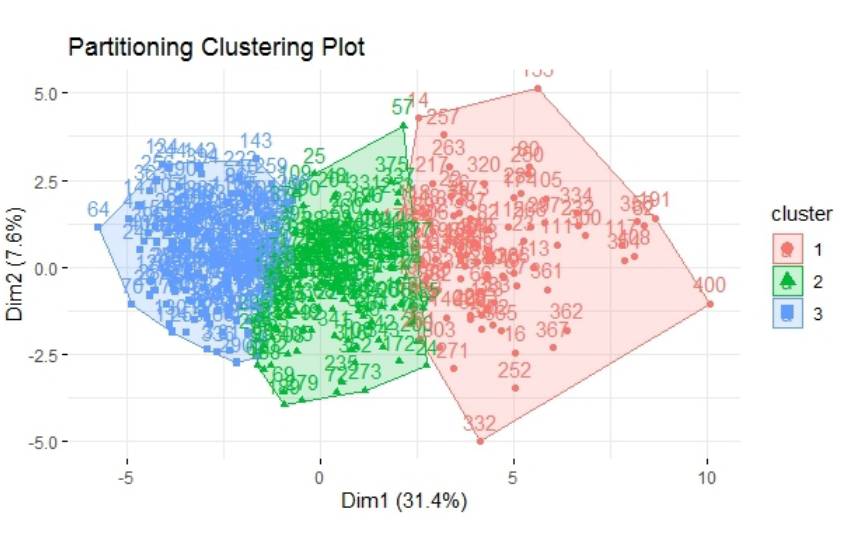
Figure 2. The visualization of the clusters along with